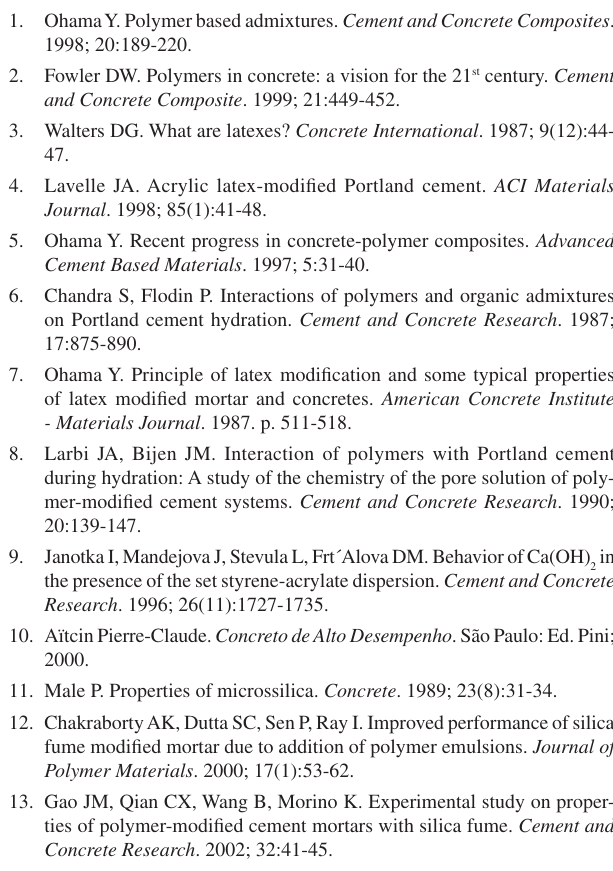
Figure 10. XRD patterns of the P5 and P6 pastes after 28 days of hydration. P. portlandite (Ca(OH) ); CC. Calcium carbonate (CaCO 2 (Ca [Al(OH) ] (SO ) .26H O); S. silicates; F. 6 6 2 4 3 2